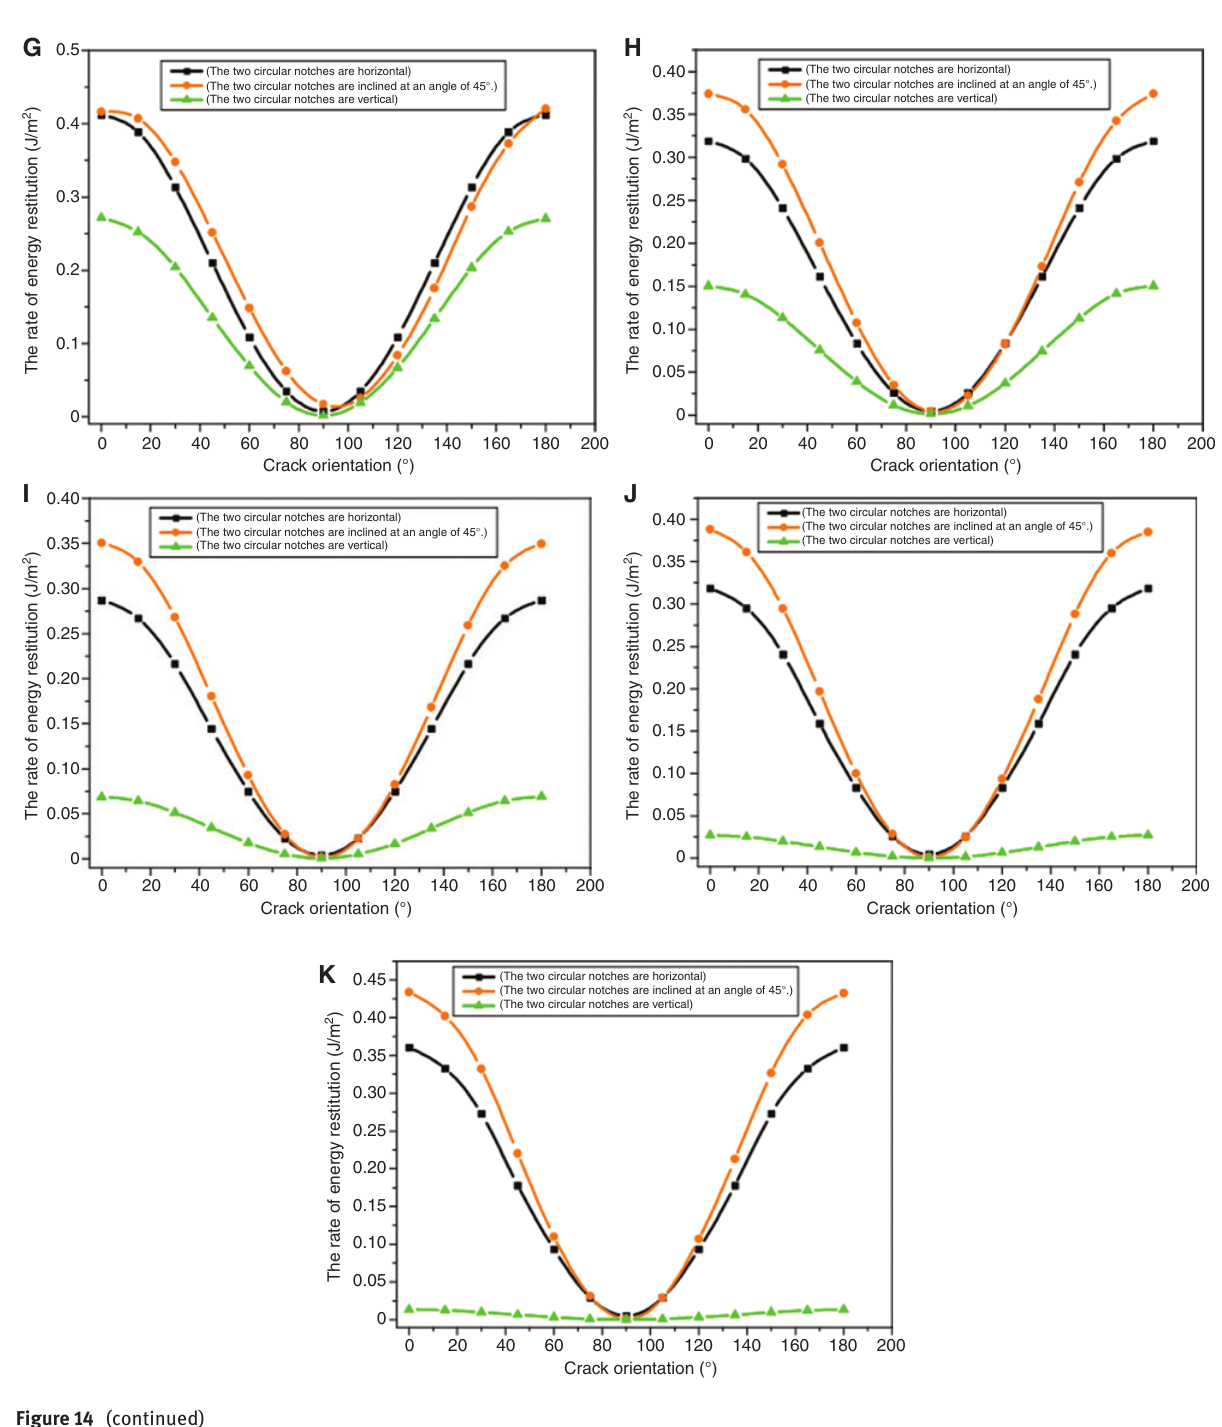
Whatever the orientation of the fibers, of the crack or the two notches, the composite material boron/epoxy behaves better than glass/epoxy material regard- mechanical properties.